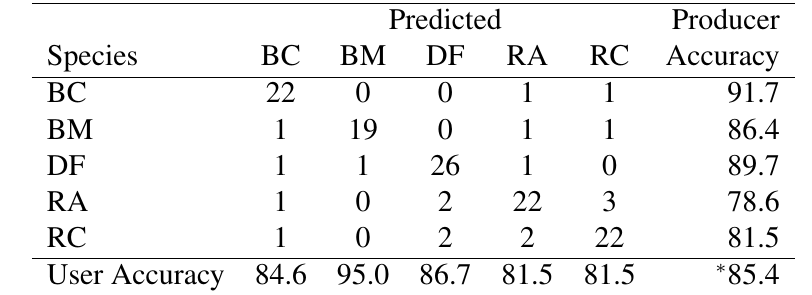
Confusion matrix for the classification of all five species using all available predictor variables from both the discrete point and waveform